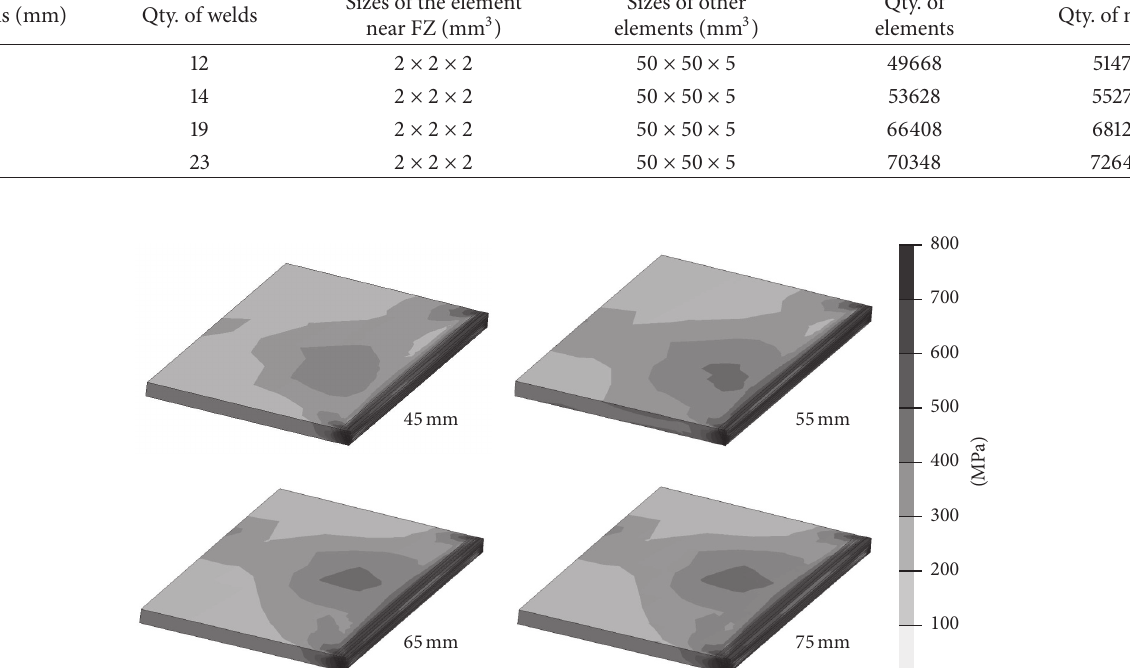
Figure 11: von-Mises